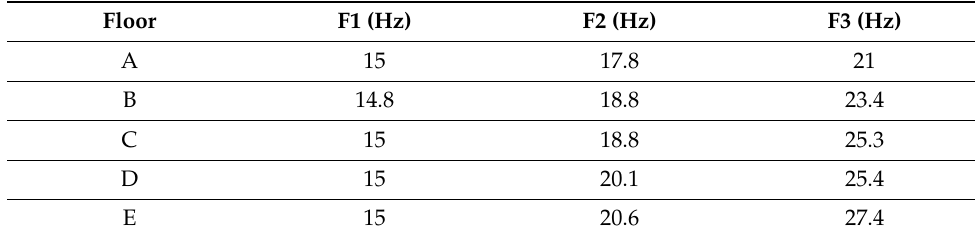
Table 5. Frequencies of the first three modes in the